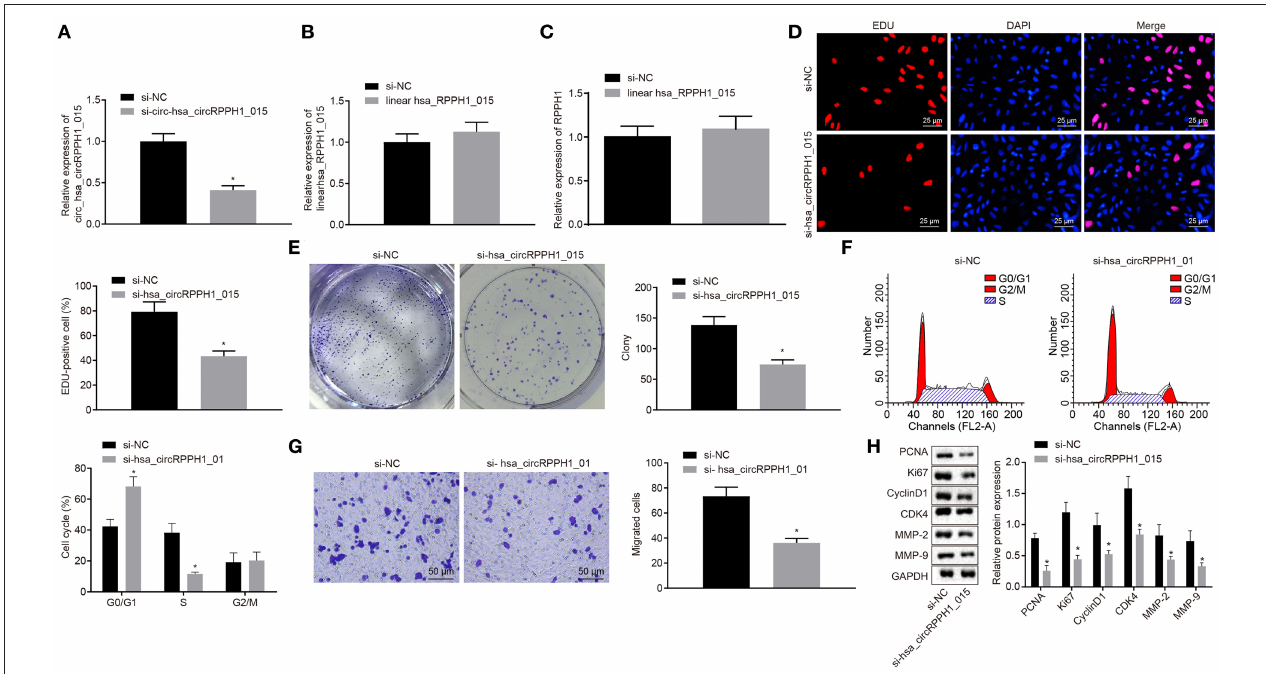
FIGURE 3 | Silencing of hsa_circRPPH1_015 exerts inhibitory effects on the proliferation and invasion of BC cells. (A) The relative expression of hsa_circRPPH1_015 in MCF-7 cells examined by TaqMan-PCR assay. (B) The relative expression of linear hsa_RPPH1_015 in MCF-7 cells examined by RT-qPCR. (C) The relative expression of ELK1 in MCF-7 cells examined by RT-qPCR. (D) MCF-7 cell proliferation assessed by EdU. (E) Representative imges of MCF-7 colony formation and the quantification diagram examined by colony formation assay. (F) MCF-7 cell cycle examined by flow cytometry. (G) MCF-7 cell invasion examined by Transwell assay. (H) The expression of related proteins in MCF-7 cells normalized to GAPDH assessed by Western blot analysis. * p < 0.05 vs. the si-NC group (MCF-7 cells transfected with si-NC). The quantitative analysis results were measurement data and compared by unpaired t -test between two groups and by one-way ANOVA among multiple groups. Values were obtained from three independent experiments. BC, breast cancer; ELK1, ETS-domain containing protein; EdU, 5-ethynyl-2 ′ -deoxyuridine; RT-qPCR, reverse transcription quantitative polymerase chain reaction; GAPDH, glyceraldehyde-3-phosphate dehydrogenase; si-NC, small interfering RNA-negative control; ANOVA, analysis of